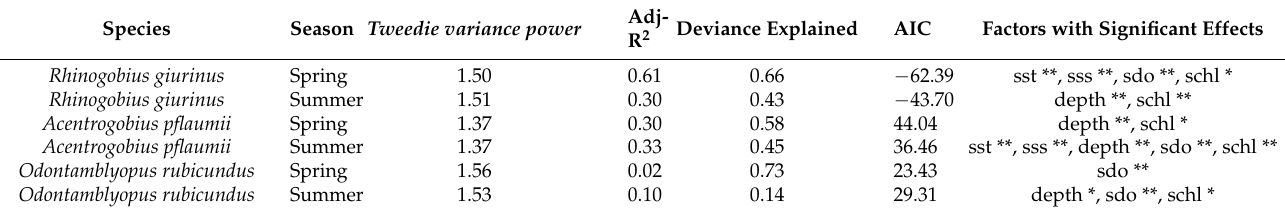
Table 3. The regression of SI and observed density of gobies in the Yangtze Estuary.